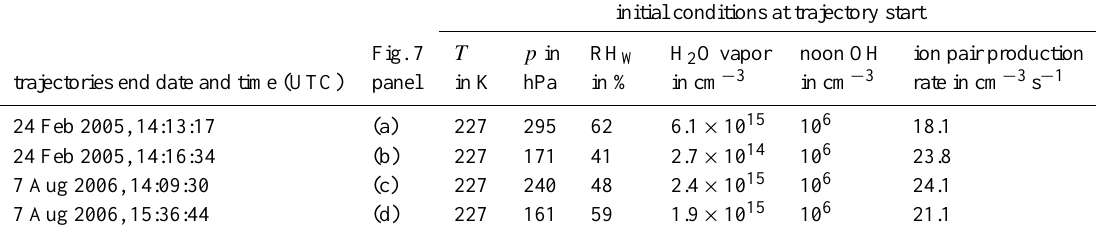
Table 2. Input parameters for MAIA model runs for calculations of the ion-induced and neutral aerosol nucleation for the case studies displayed in Fig. 7. Values of temperature ( T ), pressure ( p ) and relative humidity with respect to water (RH W ) are given at the time the NPF is initialized after convective uplift. Water vapor and OH are given in number of molecules per cm 3 of air. initial conditions at trajectory start Fig. 7 T p in RH W H 2 O vapor noon OH ion pair